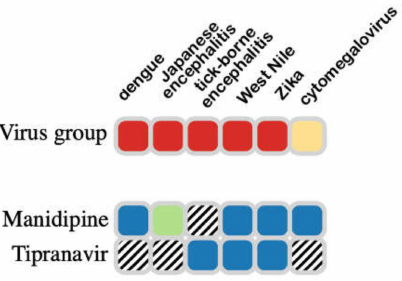
Figure 8. Confirmation of experimental antiviral activity for two of the lead hits, shown to have antiviral activity in (cell assays (blue) or animal models (green). From https://drugvirus.info/ (accessed on 1 April